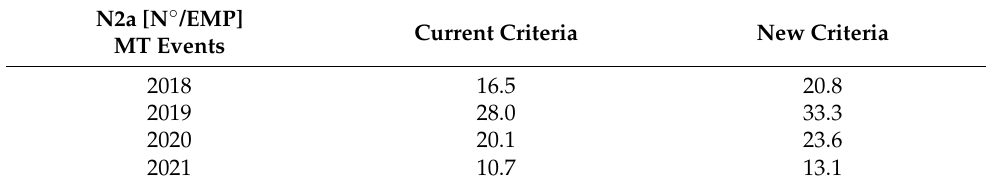
Table 9. N2a comparison: MV